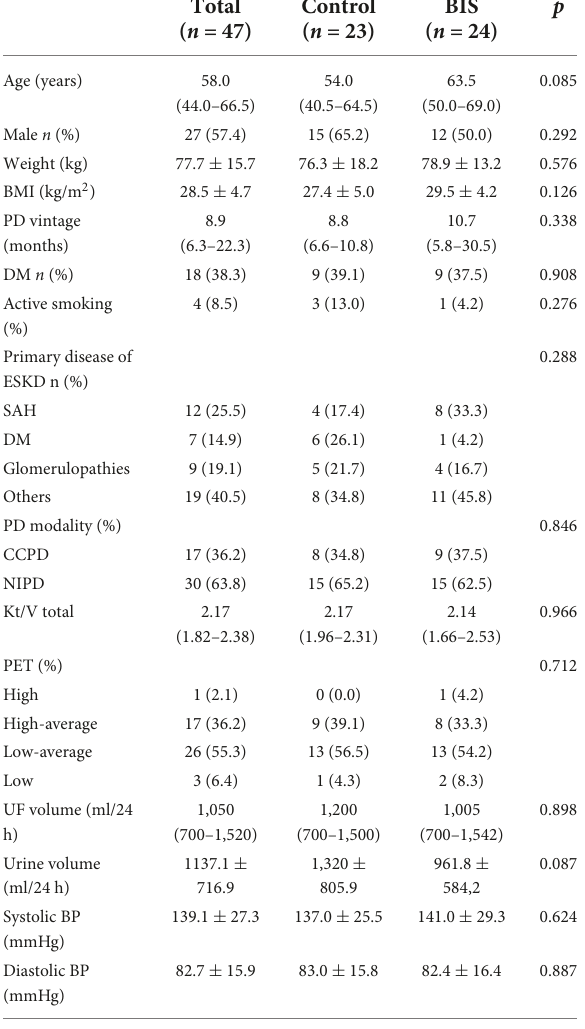
TABLE 1 Demographic, clinical, and dialysis characteristics of the control and BIS groups at baseline.